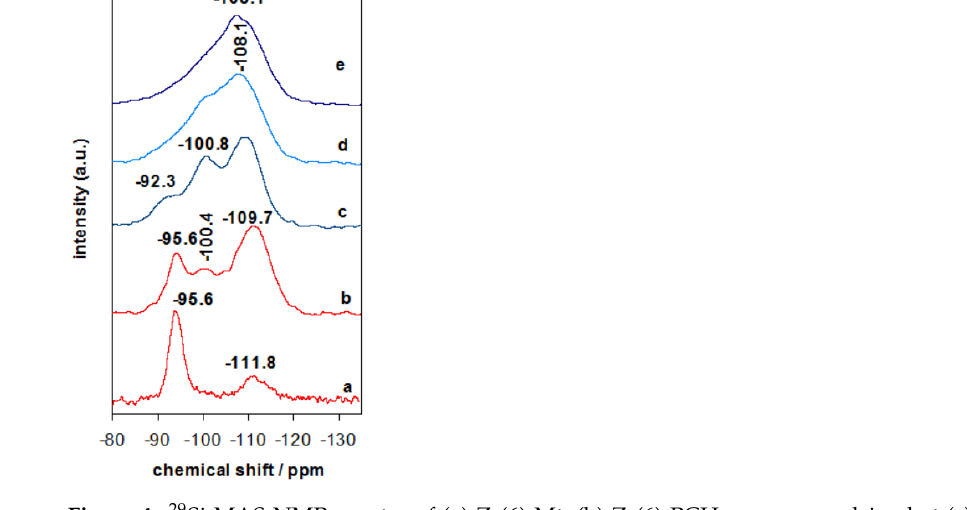
Figure 4. 29 Si ‐ MAS ‐ NMR spectra of (a) Zr(6) ‐ Mt, (b) Zr(6) ‐ PCH precursor calcined at (c) 550 °C, (d) ◦ C, and (e) 900 ◦ 650 °C, and (e) 900 °C. (d) 650